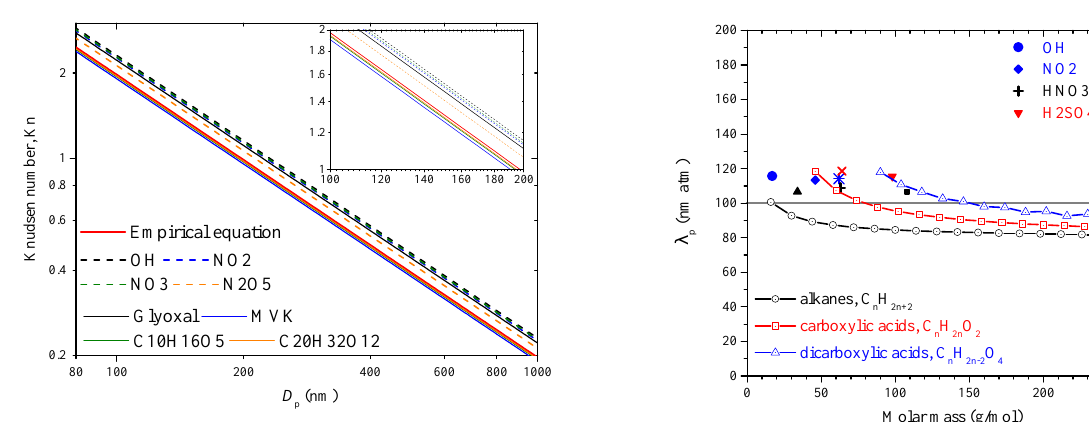
Figure 3. Mean free paths for different inorganic and organic species in 1atm air. Three types of organic compounds (alkanes, carboxylic acids and dicarboxylic acids) containing different num- bers of carbon atoms are